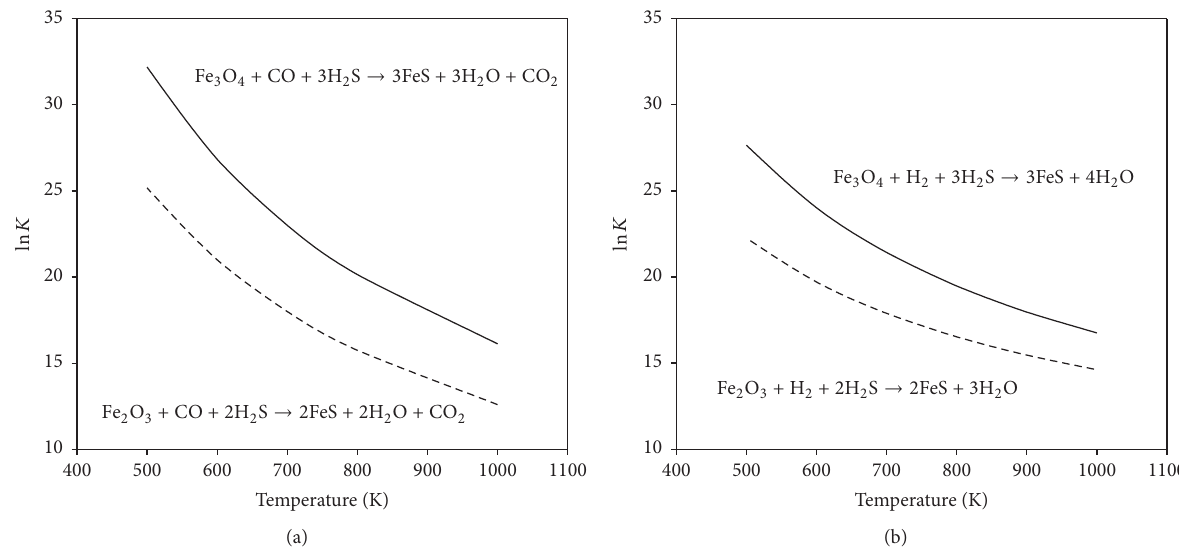
Figure 2: The thermodynamic calculation of the reactions between iron oxides and H 2 S at high temperature.